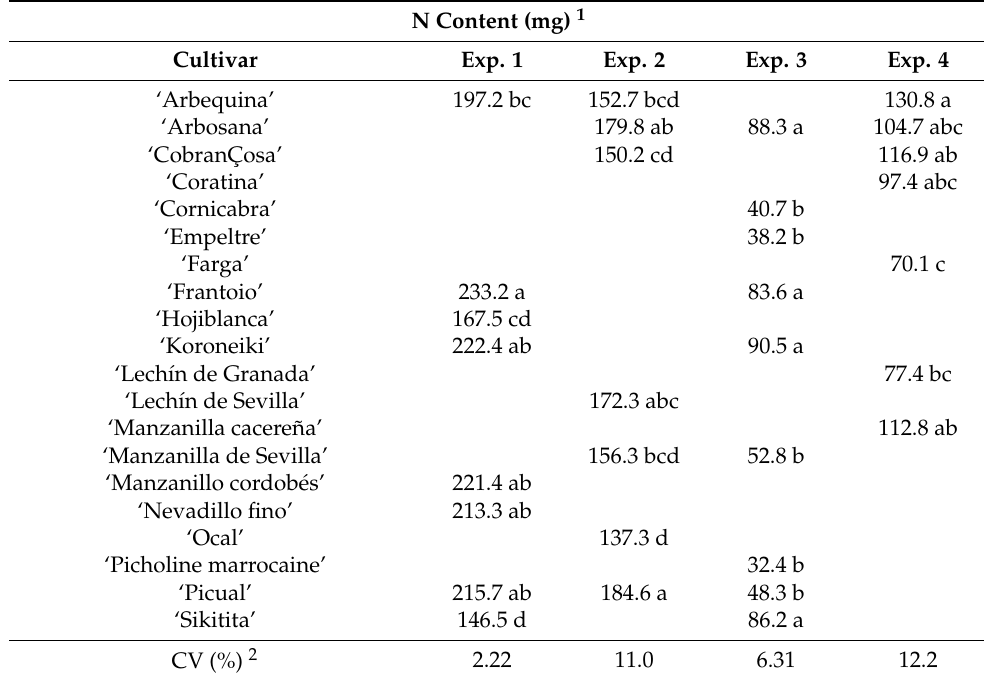
Table 2. Total nitrogen content in plants of 20 olive cultivars in response to 100 ppm N